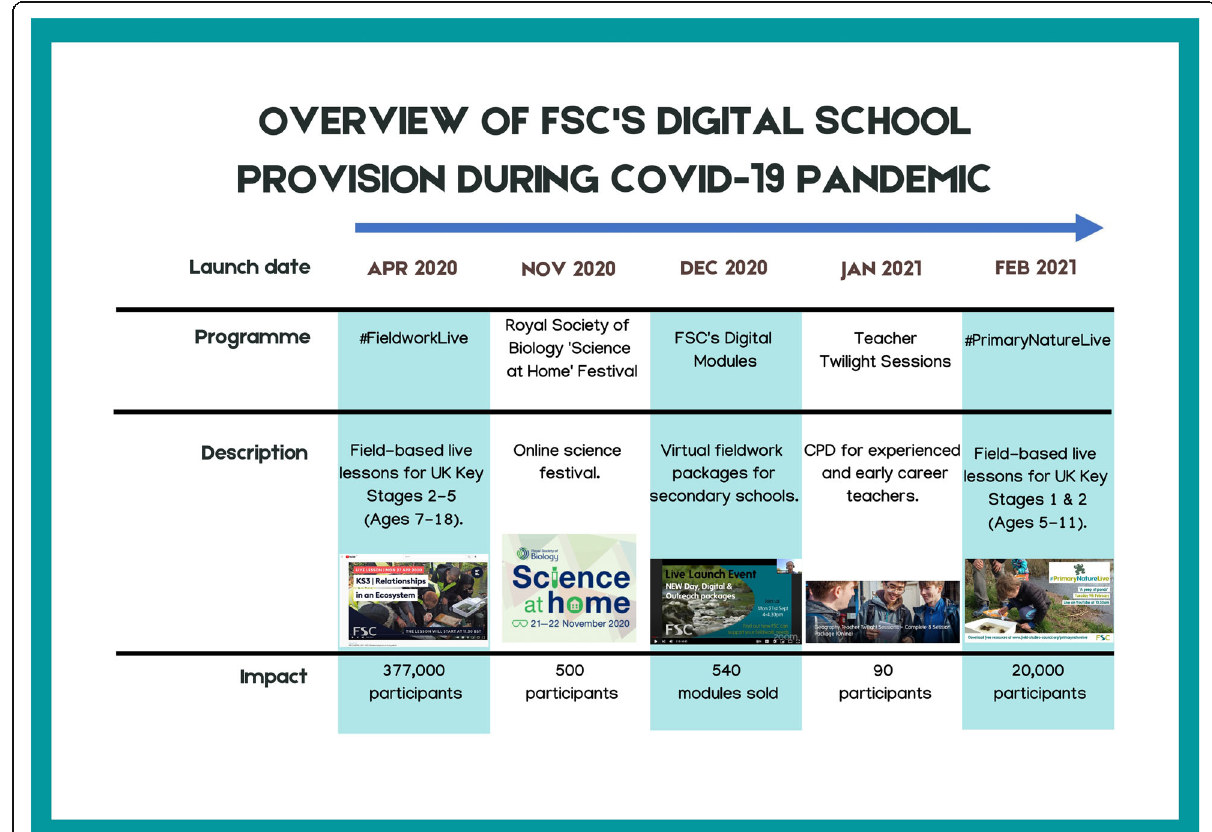
Fig. 1 Overview of FSC ’ s digital school provision during the COVID-19